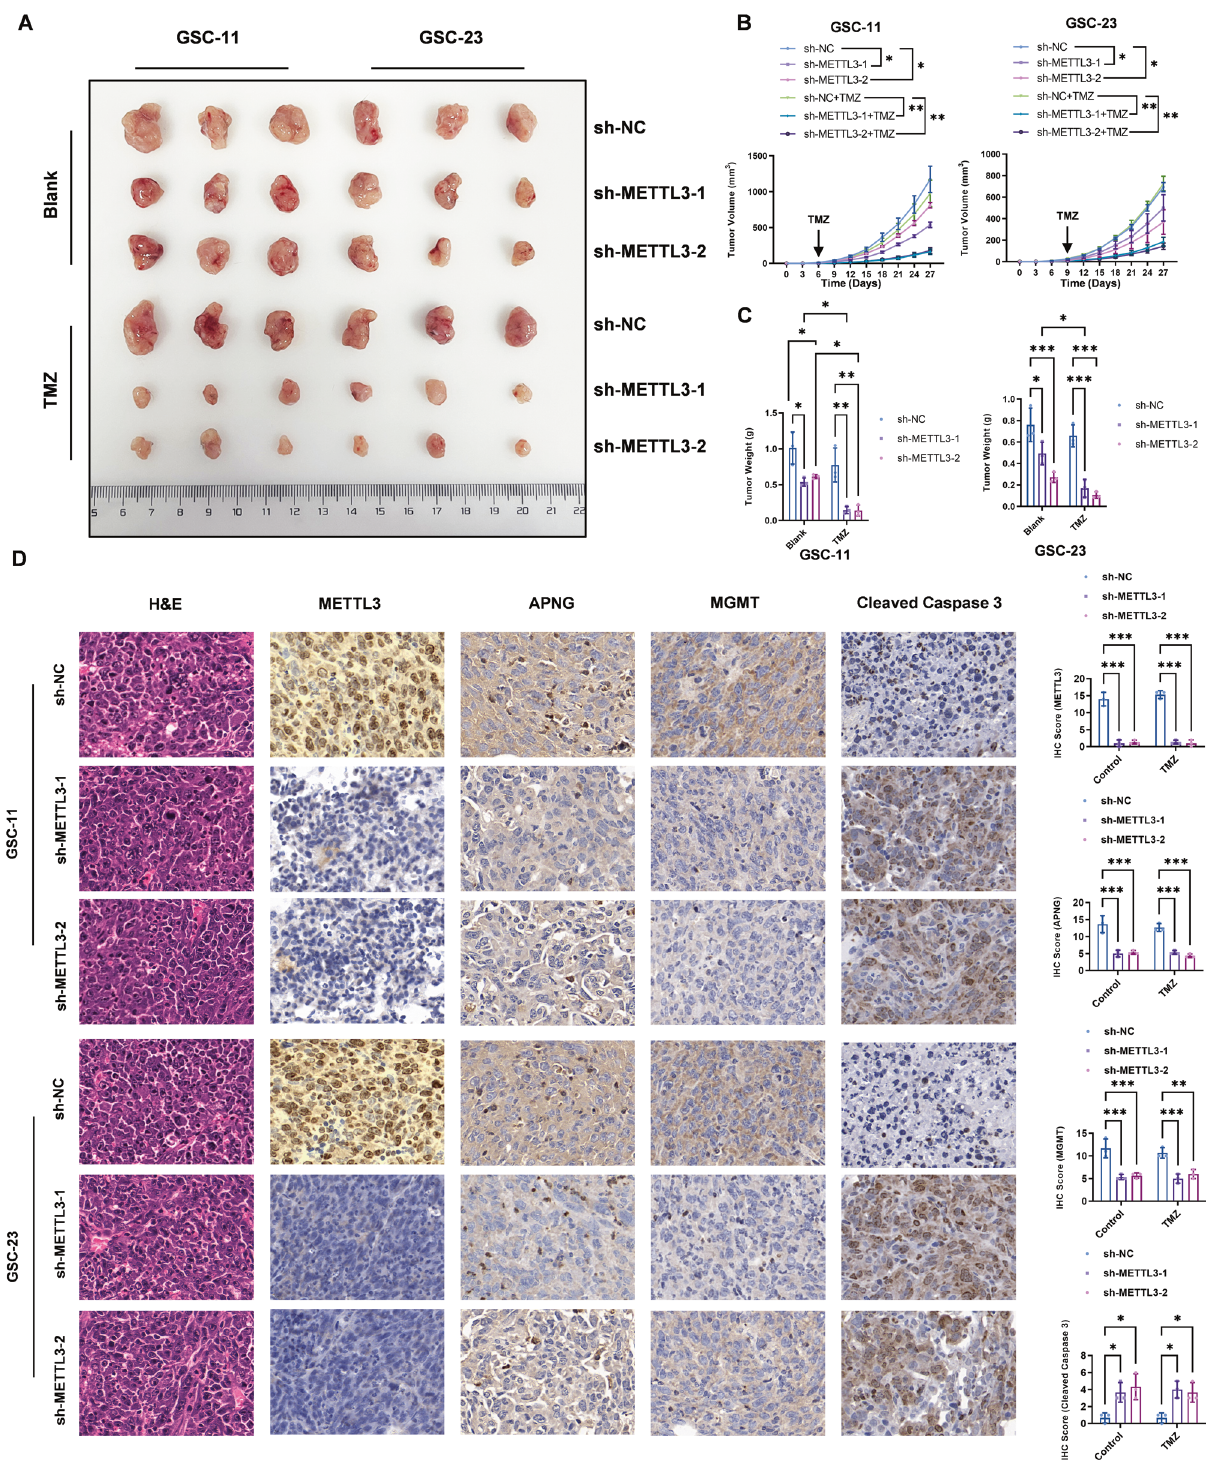
Fig. 5 In vivo tumorigenicity assay disclosed METTL3 knockdown improved TMZ sensitivity of GSCs. A The xenograft tumor size of NC or METTL3 knockdown GSC-11 and GSC23 cells with or without TMZ treatment. B Tumor growth curve. C Weight of the implanted tumors from GSCs in subcutaneous xenograft model of BALB/c nude mice with or without TMZ treatment. D IHC analysis of METTL3, MGMT, APNG, and cleaved caspase-3 in subcutaneous model. * P ＜ 0.05, ** P ＜ 0.01, *** P < 0.001 versus indicated groups.